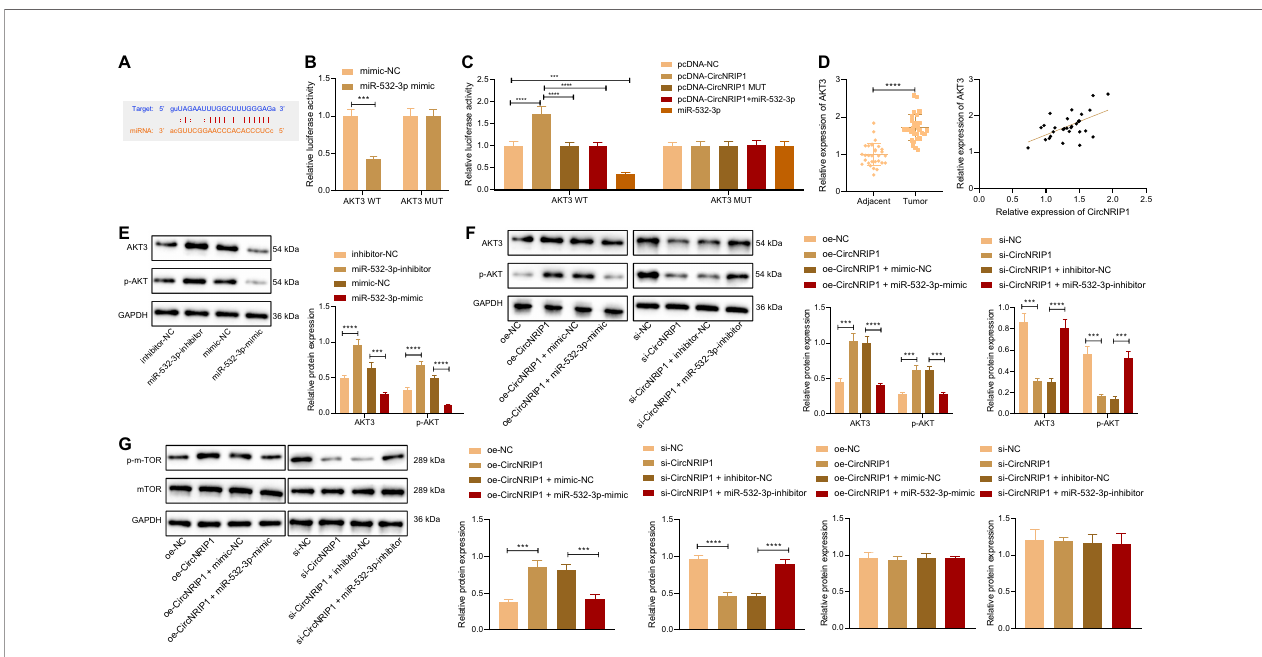
FIGURE 5 | circNRIP1 increases the expression of AKT3 by competitively binding to miR-532-3p. (A) Predicted binding sites between miR-532-3p and AKT3 by the StarBase database. (B) Binding of miR-532-3p to AKT3 con fi rmed by dual-luciferase reporter assay in HEK-293T cells. (C) Binding between circNRIP1, miR-532-3p, and AKT3 con fi rmed by dual-luciferase reporter assay in HEK-293T cells. (D) Expression of AKT3 determined by RT-qPCR in adjacent normal and osteosarcoma tissues (the left), and the correlation of AKT3 with circNRIP1 analyzed by Pearson ’ s correlation coef fi cient in osteosarcoma tissues (the right). (E) Western blot analysis of AKT3 and p- AKT3 protein levels in MG63 cells transfected with miR-532-3p mimic or inhibitor. (F) Western blot analysis of AKT3 and p-AKT3 protein levels in MG63 cells treated with oe-circNRIP1, si-circNRIP1, oe-circNRIP1 + miR-532-3p mimic, or si-circNRIP1 + miR-532-3p inhibitor measured by Transwell assay. (G) Western blot measurement of p-mTOR and mTOR protein levels in MG63 cells in response to circNRIP1 overexpression/knockdown. *** p < 0.001. **** p < 0.0001. Data are shown as mean ± standard deviation of three technical replicates. Data between osteosarcoma tissues and adjacent normal tissues were compared using paired t -test and those between the other two groups by unpaired t -test. Data among multiple groups were compared with one-way ANOVA, followed by Tukey ’ s post hoc tests.